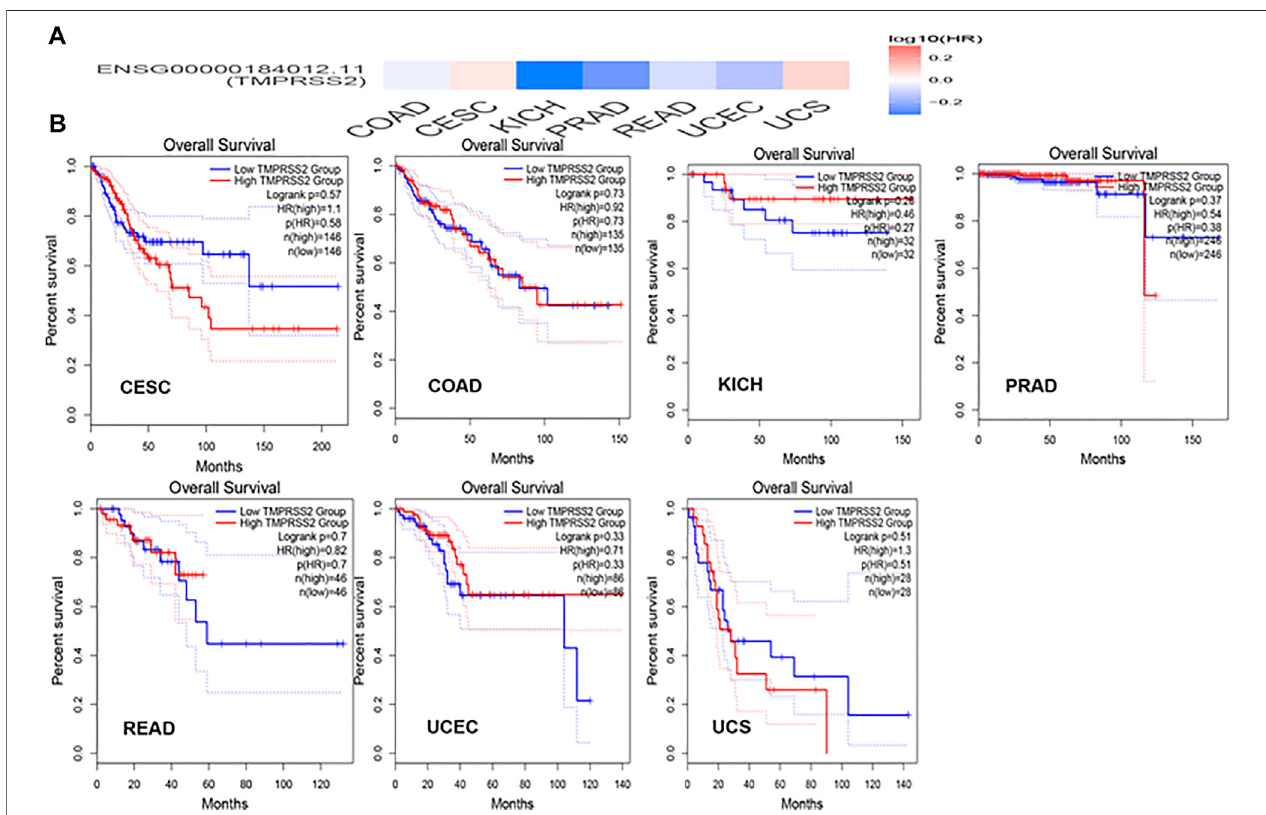
FIGURE 8 | Expression level of TMPRSS2 in different pathological stages. Based on TCGA data, the expression level of TMPRSS2 was analyzed according to the main pathological stages (stage I, stage II, stage III, and stage IV) of KICH, ESCA, KIRC, TGCT, THCA, and KIRP.